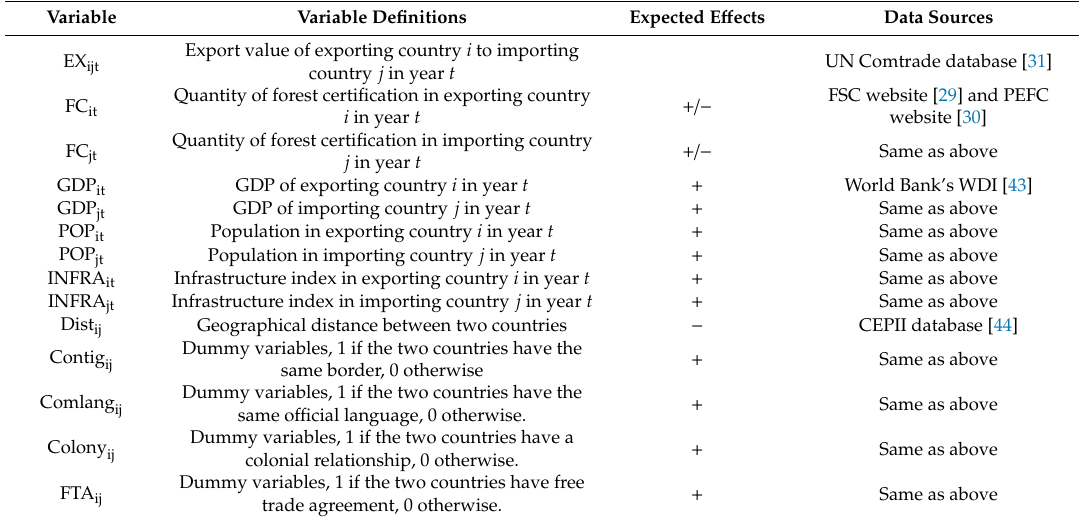
Table 4. Definition of variables and data